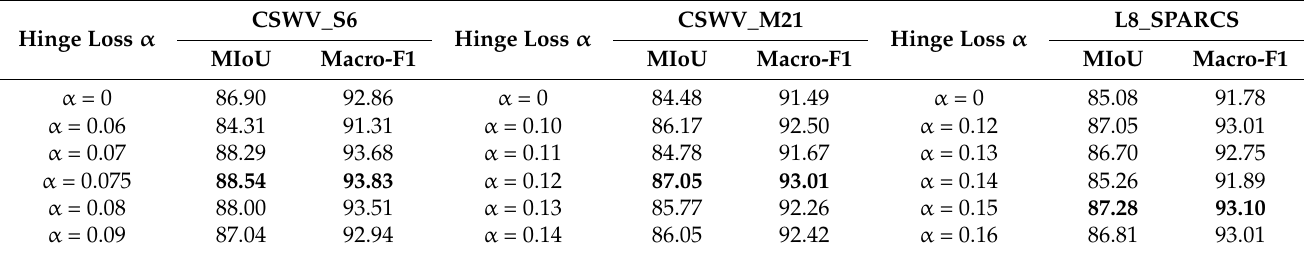
Table 7. Comparison of CSD-Net accuracy with different dilation